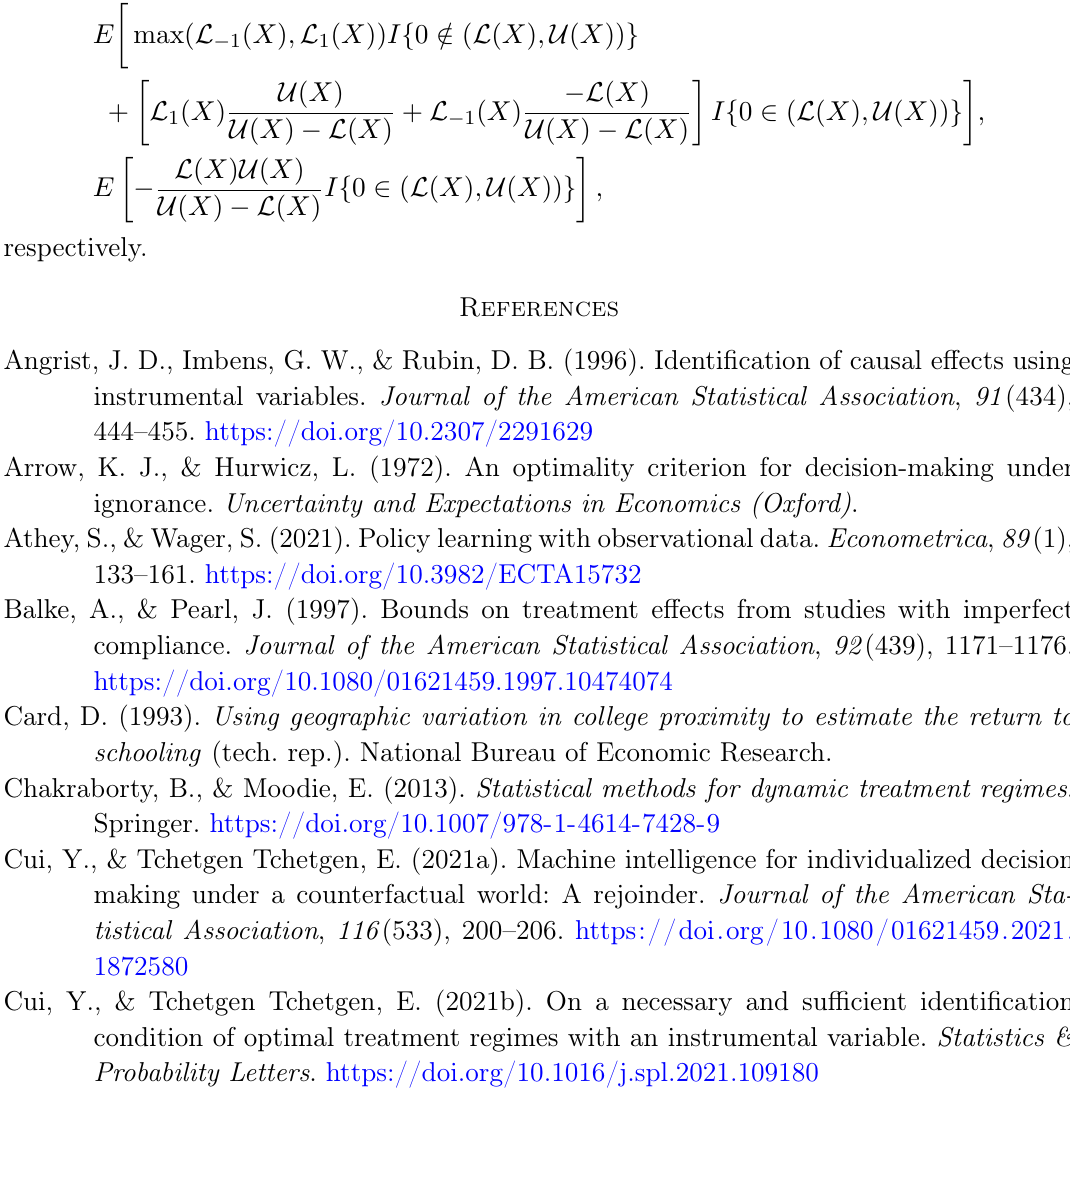
respectively. The minimum value function and maximum regret of the minimax rule in Table 1 are: (cid:104) E max( L ( X ) , L ( X )) I { 0 / ∈ ( L ( X ) , U ( X )) − 1 1